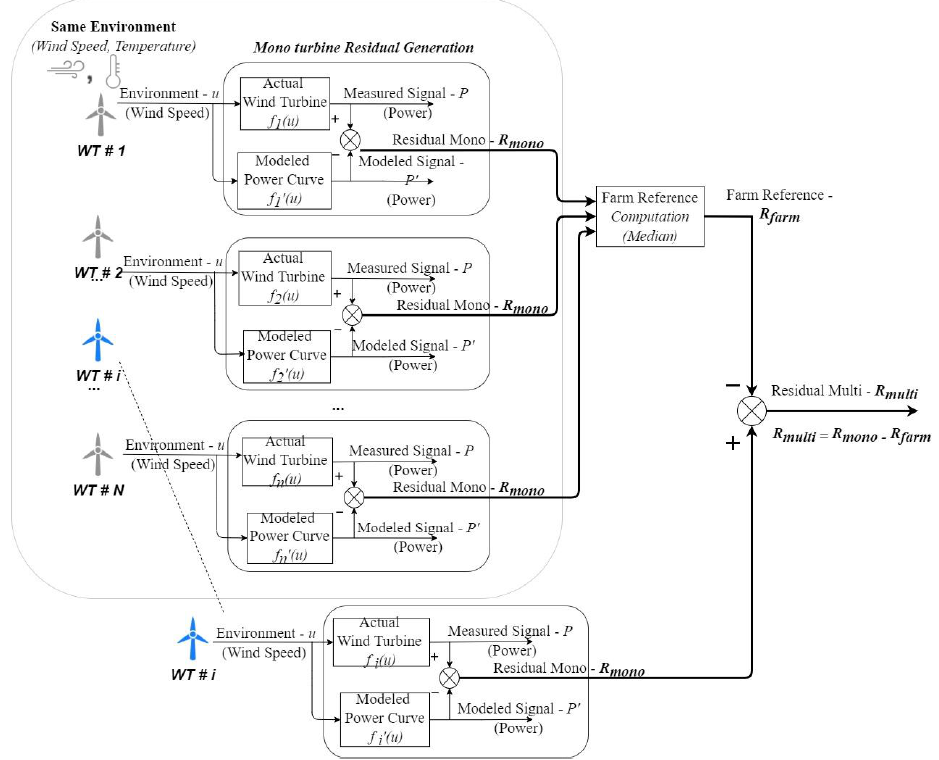
Figure 2. Overview of the hybrid multi-turbine approach: generic principle for the synthesis of fault indicator 𝑅 𝑚𝑢𝑙𝑡𝑖 for wind turbine 𝑖 . The mono-turbine residual 𝑅 𝑚𝑜𝑛𝑜 is used for calculating farm reference 𝑅 𝑓𝑎𝑟𝑚 and consequently the hybrid mono-multi-turbine residual.